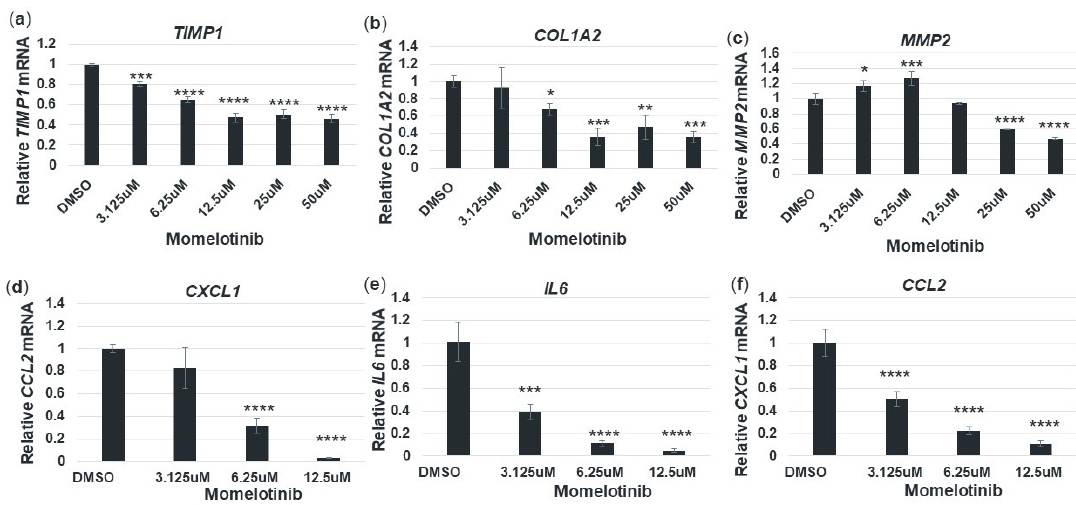
Figure 5. Momelotinib decreases the expression of profibrotic and proinflammatory genes in primary HSCs. Cells derived from a homozygous PNPLA3 148M donor were treated with either DMSO or momelotinib for 18 h. The cDNA was generated and used for qPCR to quantify gene expression of profibrotic genes TIMP1 , COL1A2 , and MMP2 ( a – c ), as well as proinflammatory genes CXCL1, IL6, and CCL2 ( d – f ). Experiments were performed in triplicate and a one-way ANOVA was used to determine significance. Average and SD values are shown. *, **, ***, **** indicate p ≤ 0.05, p ≤ 0.01, p ≤ 0.001, and p ≤ 0.0001, respectively.